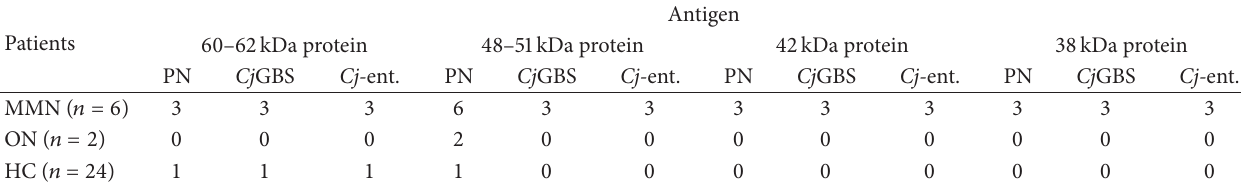
Table 2: Results from Western blot: number of patients with positive reactivity to isolated proteins. Patients